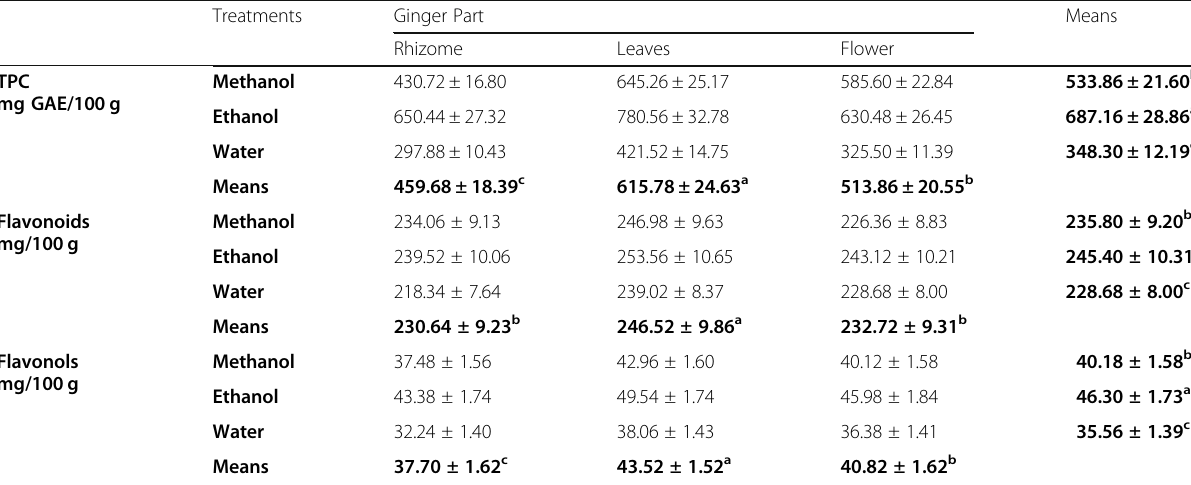
Table 2 Means for TPC, Flavonoids and Flavonols of ginger extract Treatments Ginger Part Means Rhizome Leaves Flower